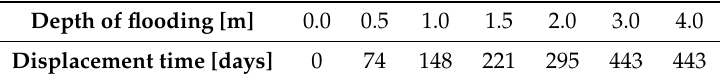
Table 4. Displacement time for flooding in residential